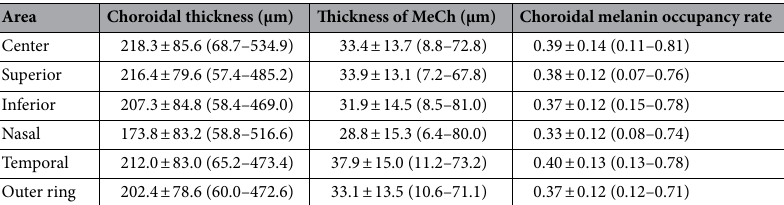
Table 3. Summary of choroidal thickness, thickness of MeCh, and choroidal melanin occupancy rate at each sector. Data are presented as mean ± standard deviation (range). Thickness of MeCh: thickness of melanin- containing tissue in the choroid, Center: center area, Superior: superior area, Inferior: inferior area, Nasal: nasal area, Temporal: temporal area, Outer ring: outer ring